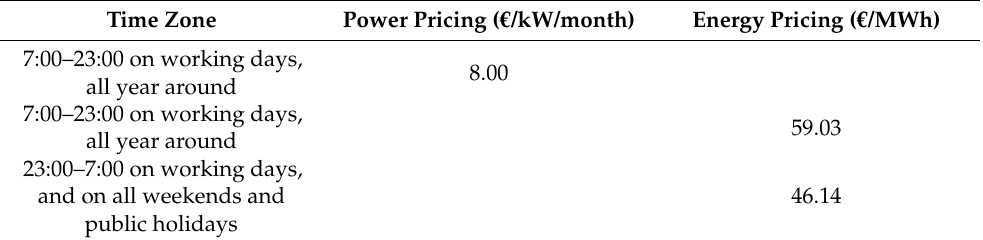
Table 10. BY electricity pricing invoice of the Public Power Corporation (PPC) in Greece (www.dei.gr, last accessed at 5 January